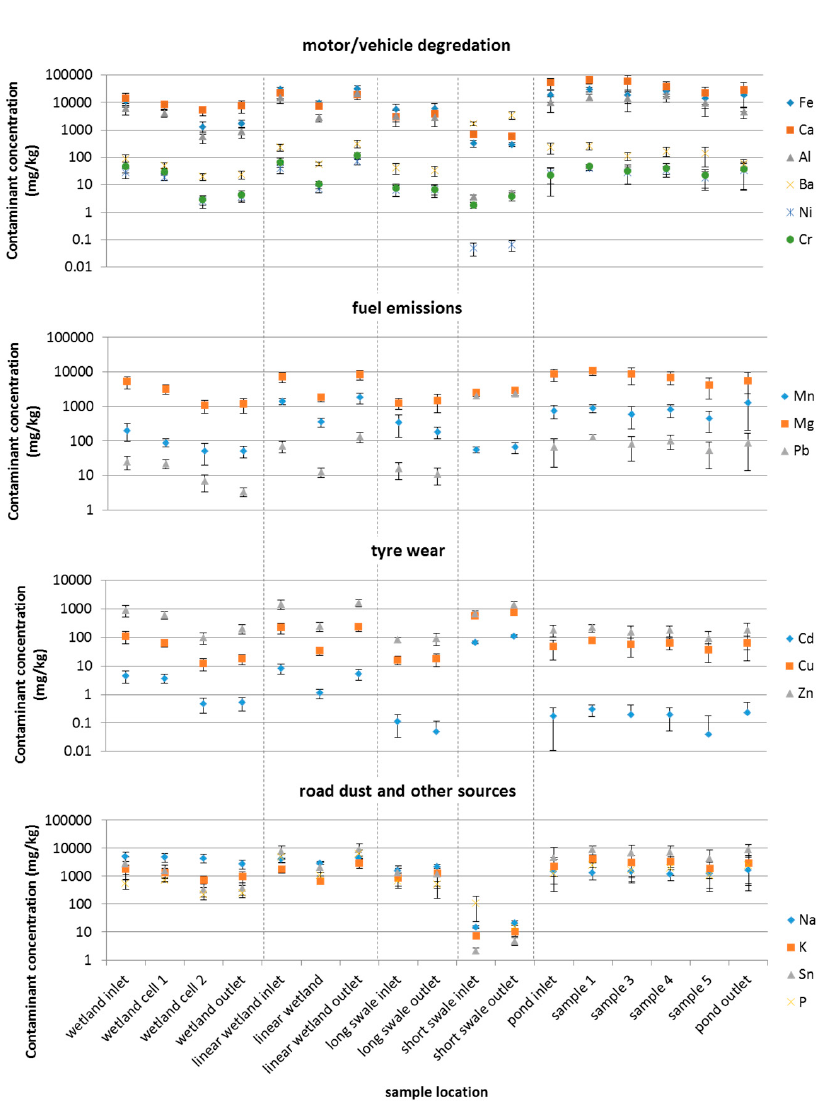
Figure 2. Sediment contaminant concentrations from monitoring points across the SuDS assets. The error bars illustrate sample range for each sample location and contaminant. Sediment contaminants have been presented relative to one of their primary urban sources (e.g., tyre wear) for ease graphical clarity.